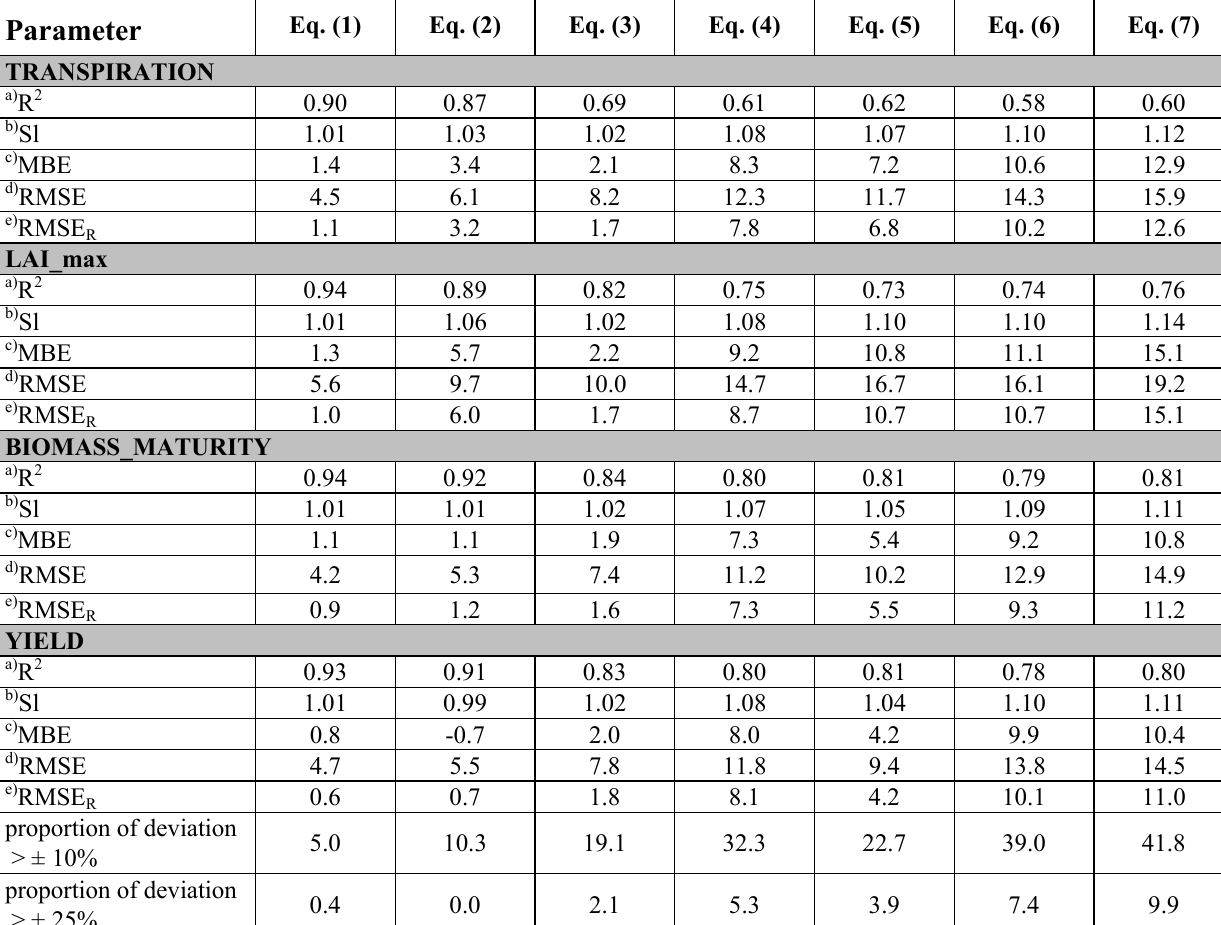
Table 5. The same as the Table 4 but for the CERES-Wheat model. The results are based on the pooled data from the 8 observational sites with total 77 complete years of weather record and three soil types i.e. 231 simulation